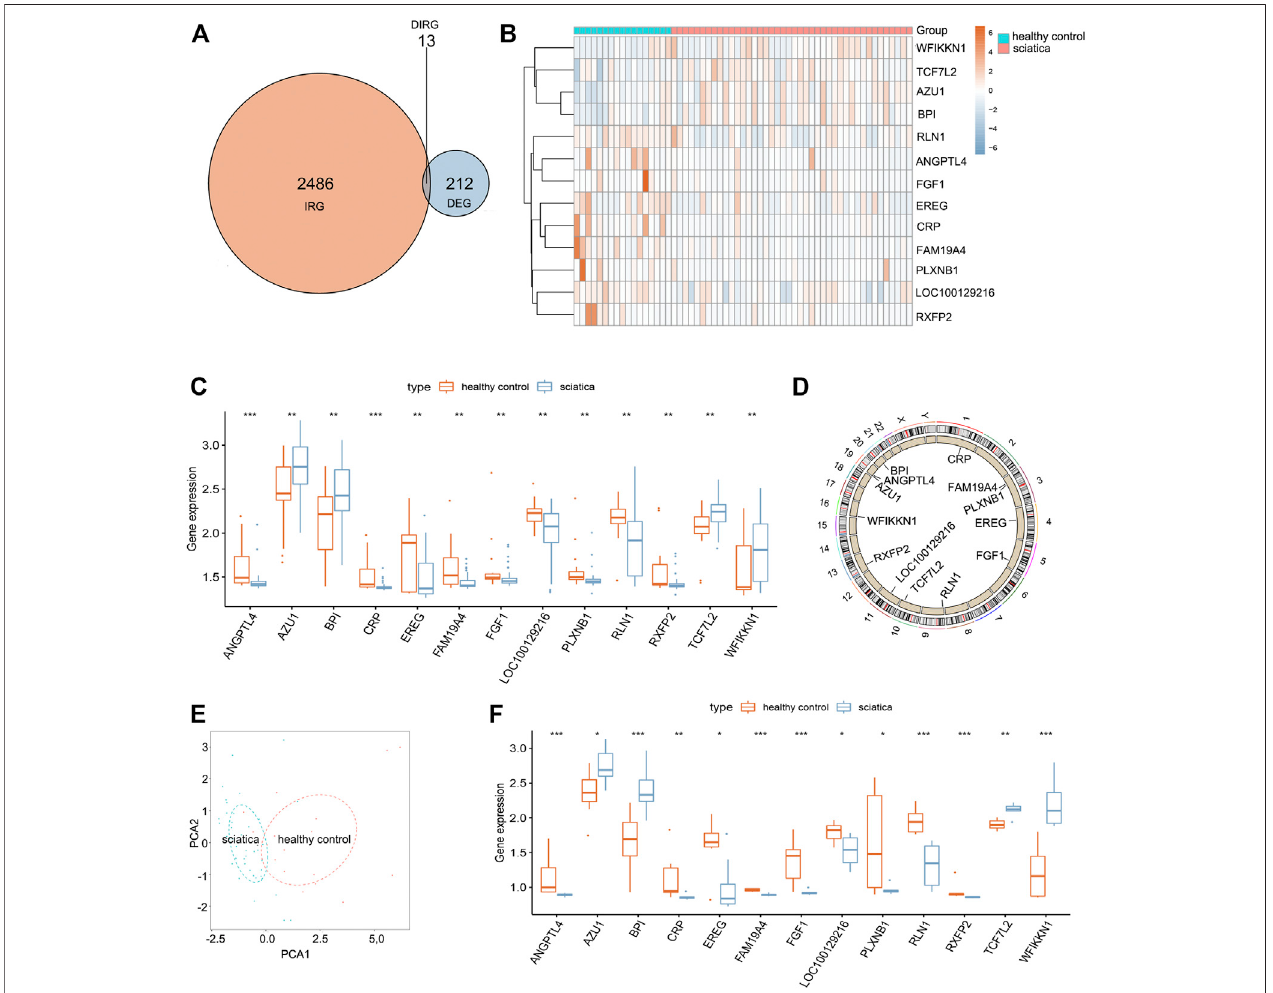
FIGURE 1 | Landscape of 13 differentially expressed immune-related genes (DEIRGs) in sciatica. (A) Identi fi cation of 13 DEIRGs. (B) Heat map showing the expression of 13 DEIRGs between sciatica patients and healthy controls in the GSE150408 dataset. (C) Histogram showing the expression of 13 DEIRGs between sciatica patients and healthy controls in the GSE150408 dataset. (D) Loop graph showing the chromosomal positions of the 13 DEIRGs. (E) PCA based on the expression of the 13 DEIRGs can distinguish sciatica patients from healthy controls. (F) Histogram showing the expression of 13 DEIRGs between eight sciatica patients and eight healthy controls based on the results of RT-qPCR